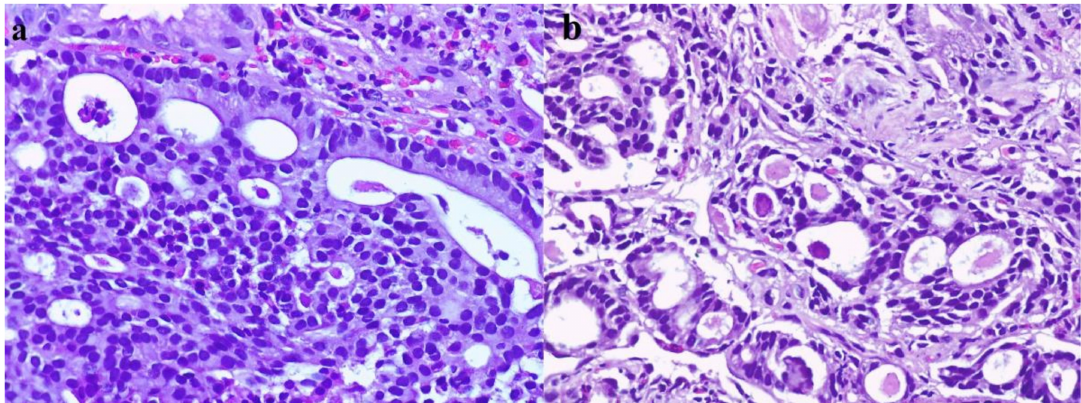
Figure 8. Histological findings. ( a ) HE, 200X. Cribriform structure with cuboidal or low columnar epithelial cells, with eosinophilic cytoplasm and round, central, monotonous nuclei, without visible nucleoli. Some necrotic cells and calcospherites are visible in the glandular lumina. ( b ) Glandular (acinar) growth pattern of the tumor with calcospherites (psammoma